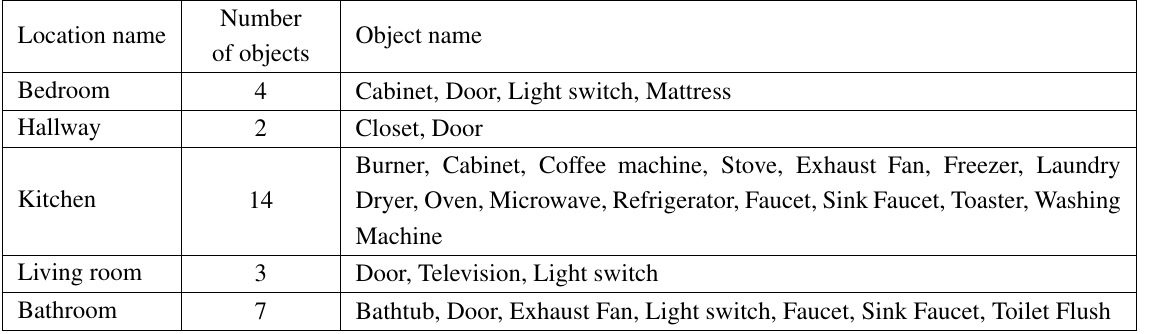
Table 3. List of objects to acquire object-usage